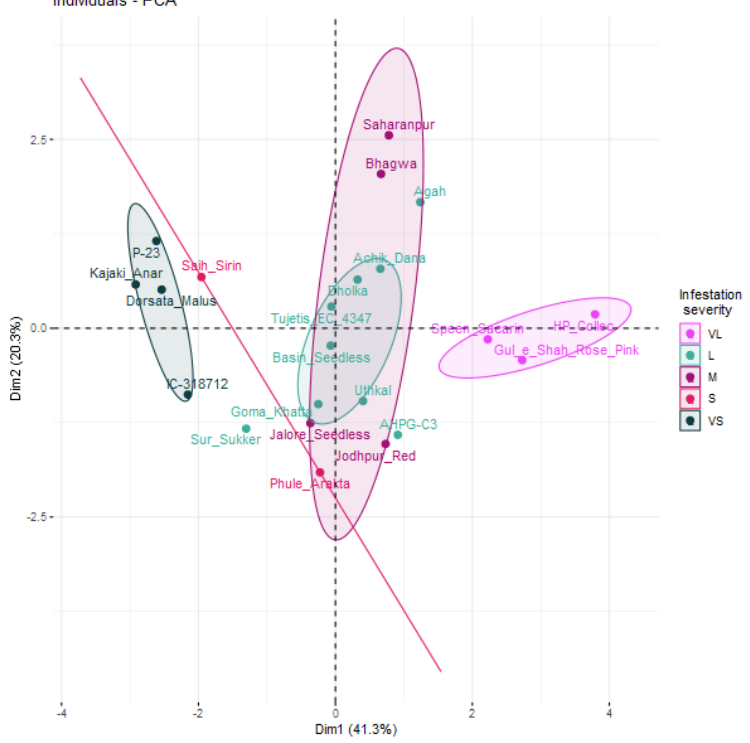
Figure 4. Bi-dimensional PCA plot of the 22 pomegranates accessions according to the morphological and phytochemical analysis. Accessions are colored according to the five classes of infestation severity (VL: very low; L: low; M: medium; S: strong; VS: very strong). For each class the graph displays the confidence interval ellipse (99%) around the mean point (not shown). The plot also reports the percentage of variance explained by each dimension.